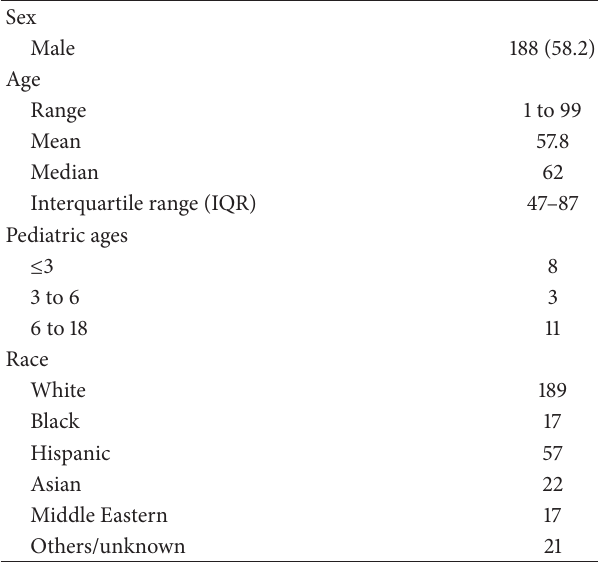
Table 2: Demographic and clinical characteristics of study subjects, 𝑁 = 323